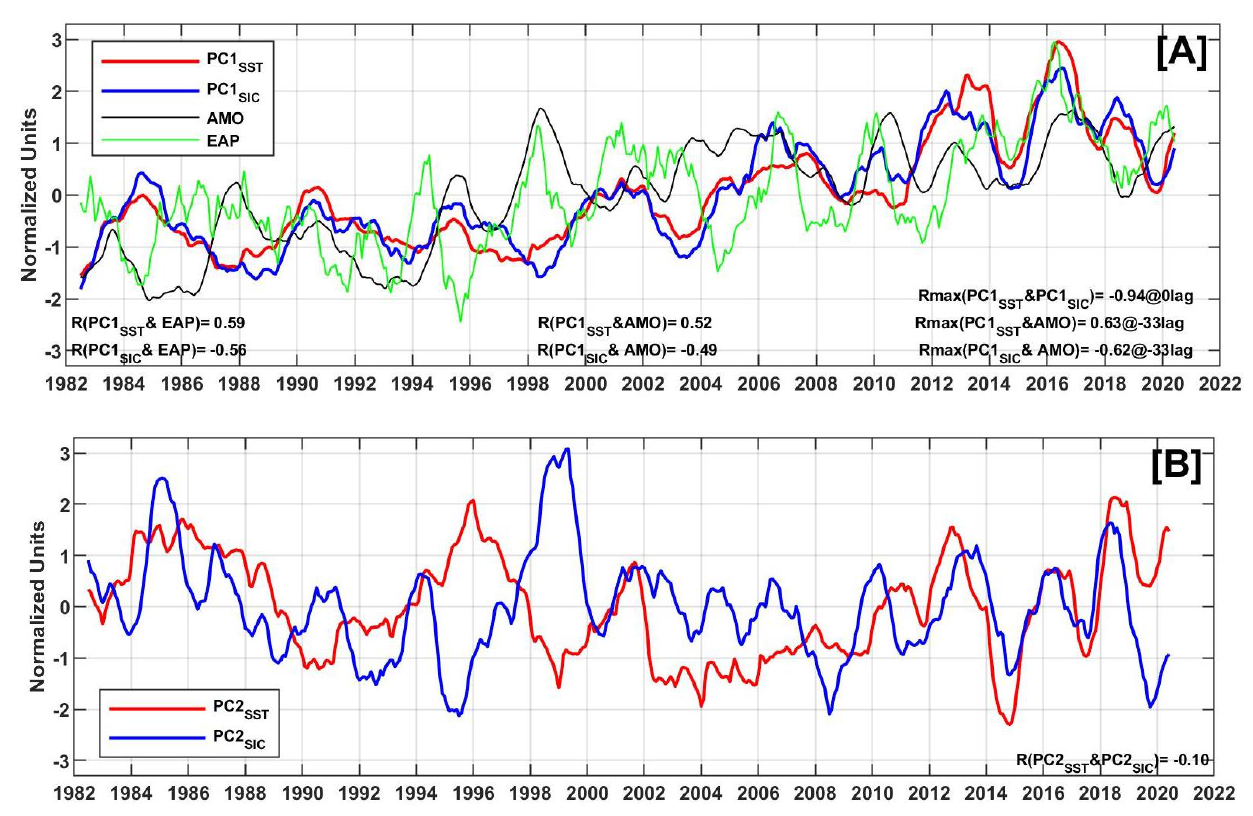
Figure 13. Normalized interannual (13-month running mean) time series of ( A ) the first principal component (PC1) for SST (red line) and SIC (blue line) anomalies in normalized variance units along with the AMO index (black line) and the EAP (green line) over the period 1982 – 2020. ( B ) The second principal component (PC2) for both SST (red line) and SIC (blue line), which are not statistically significantly correlated with any of the climate indices. Note that for SIC, the positive value of PC1 SIC and PC2 SIC corresponds to the decrease of sea ice (negative SIC anomalies), as we draw the inverted SIC PCs for better visualization.